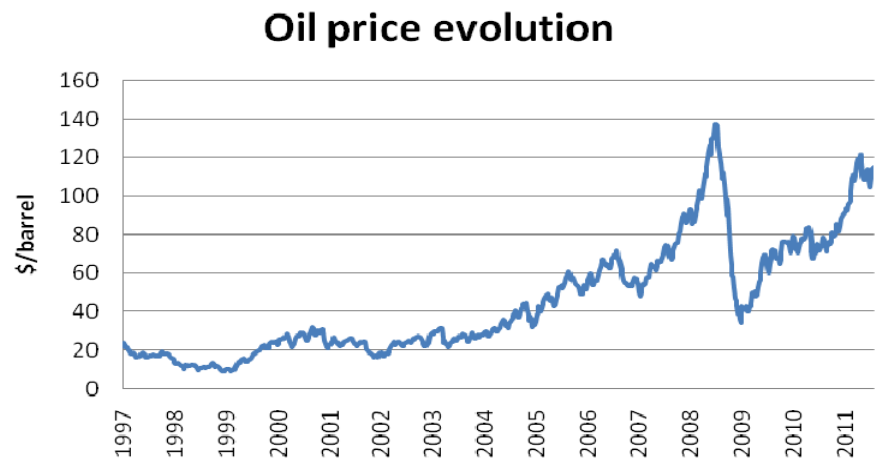
Figure 6. Oil price evolution